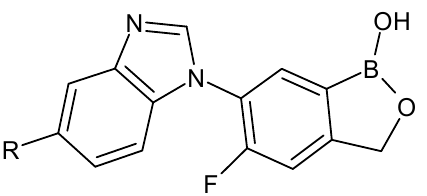
Figure 2. The structures of benzoxaborole analogs of flubendazole.